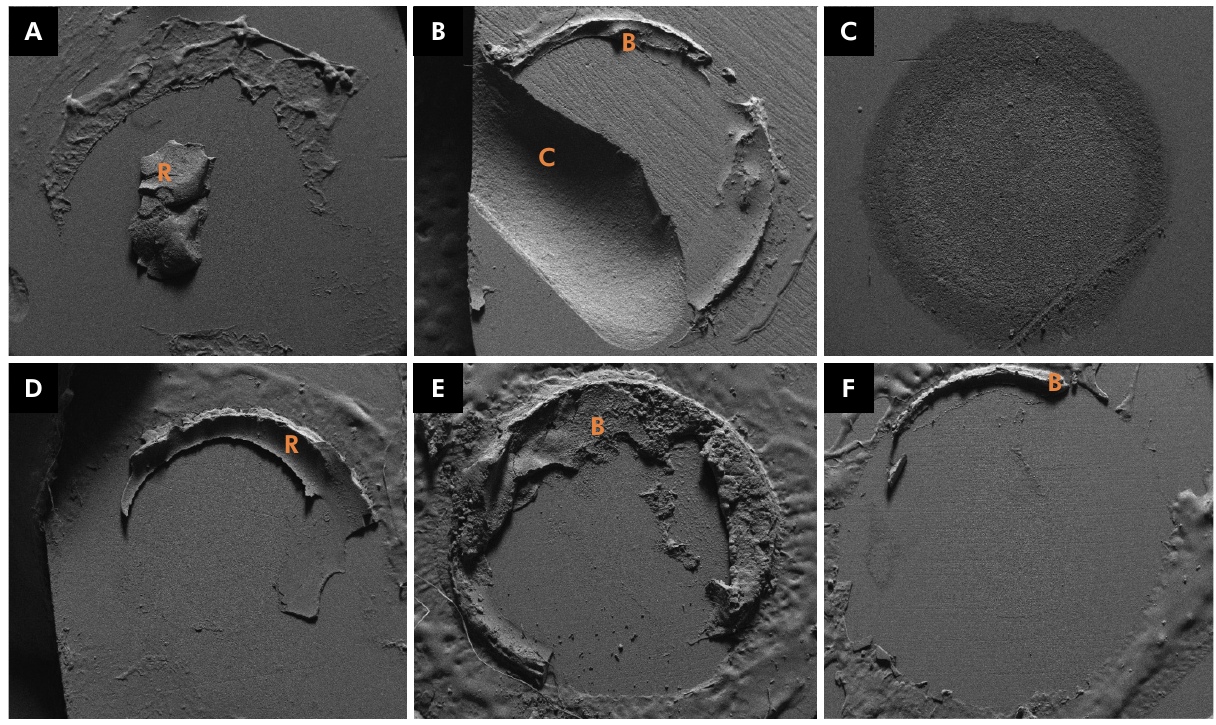
Figure 1. Micrographs of failures mode (70x). A) Cohesive Resin; B) Cohesive Ceramic; C) Adhesive; D) Mixed with Resin remaining; E) Cohesive Bonding Agent; F) Mixed with Bonding Agent remaining. (R), (C) and (B) are the resin, ceramic and bonding agent remaining,